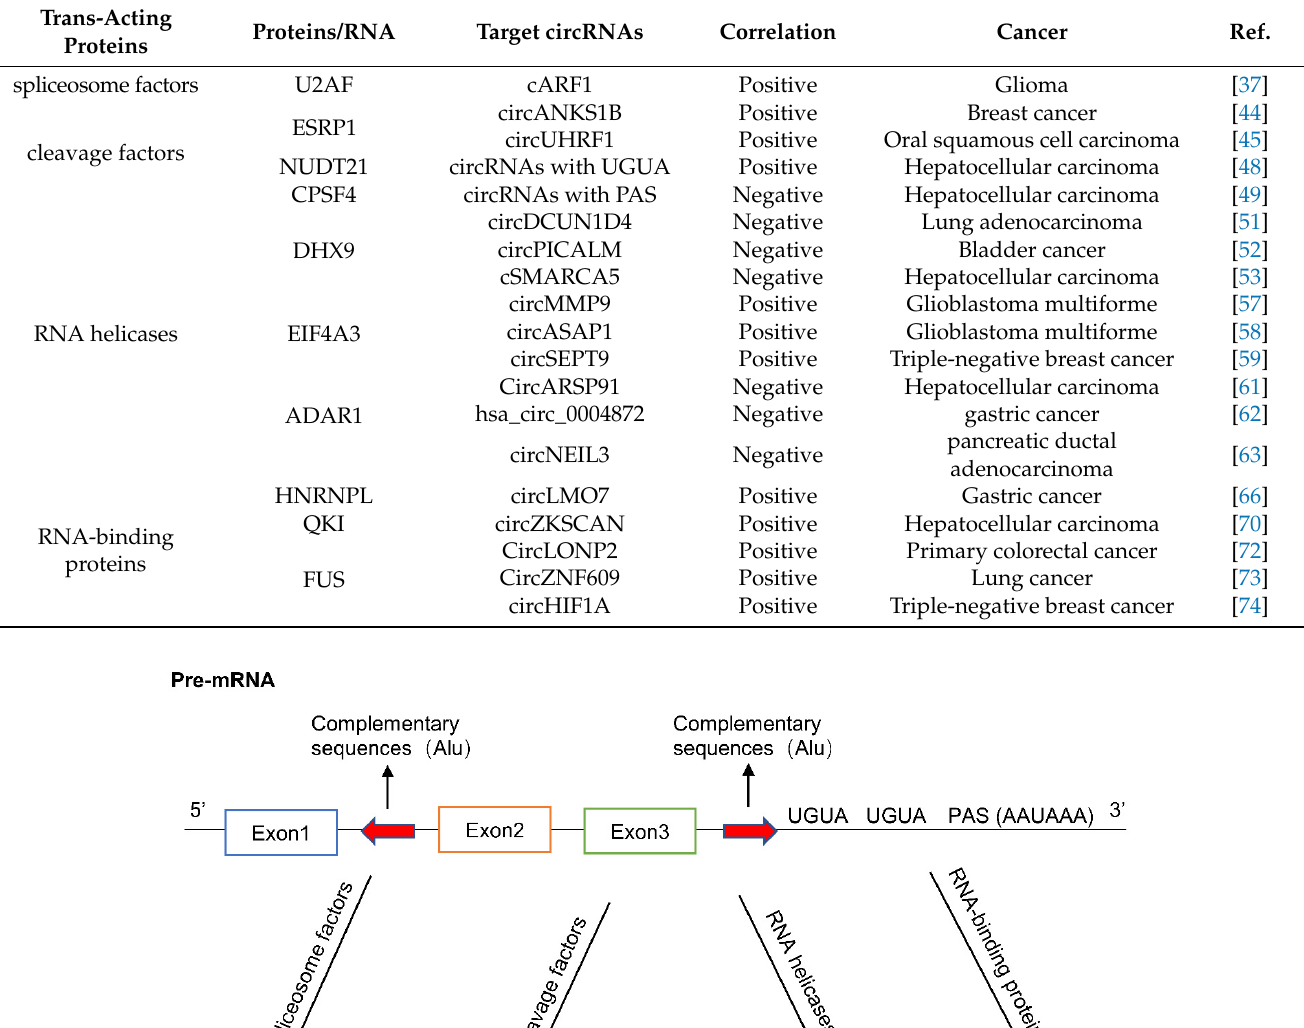
Table 1. Trans-acting proteins and RNAs for RNA circulation.